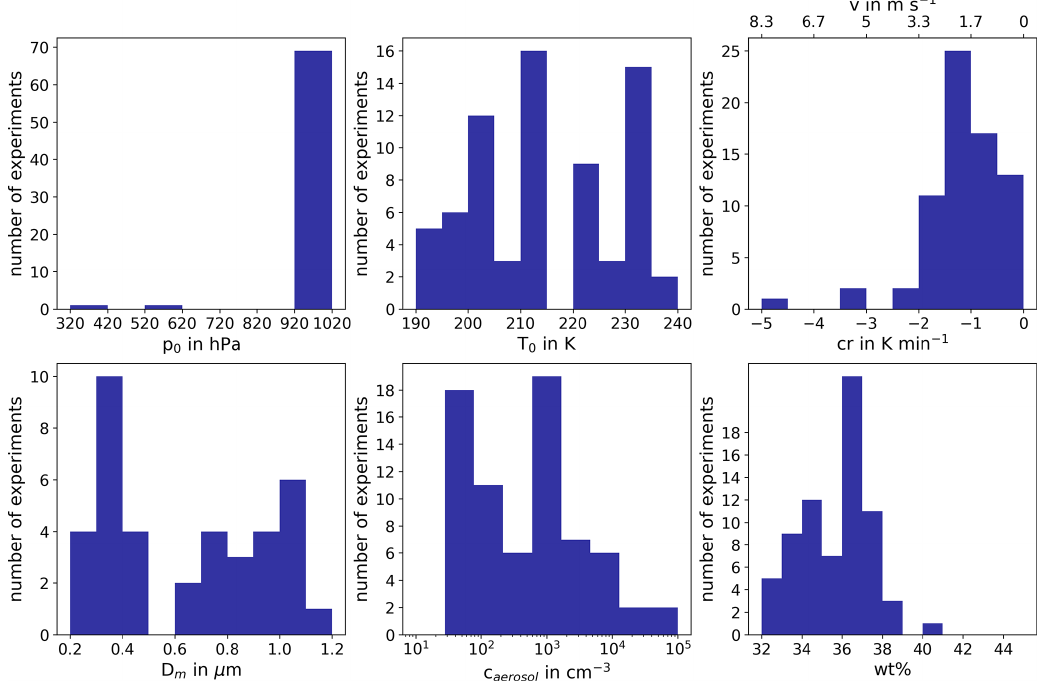
Figure B1. Overview of experimental conditions. The six histograms show the distribution and the parameter range of starting pressure p 0 , starting temperature T 0 , cooling rate cr, vertical velocity v , median aerosol particle diameter D m , aerosol particle number concentration c aerosol and weight percentage wt% of H 2 SO 4 in the aqueous solution particles before experiment